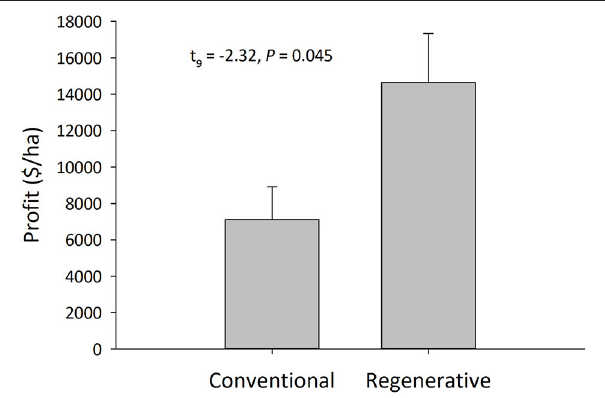
FIGURE 6 | Net profitability of regenerative and conventional almond production systems (Welch’s two-sample t -test; mean ± SEM, N = 13, α = 0.05). A producer survey was used to determine management practices, costs, and revenues that contributed to the direct net profitability of